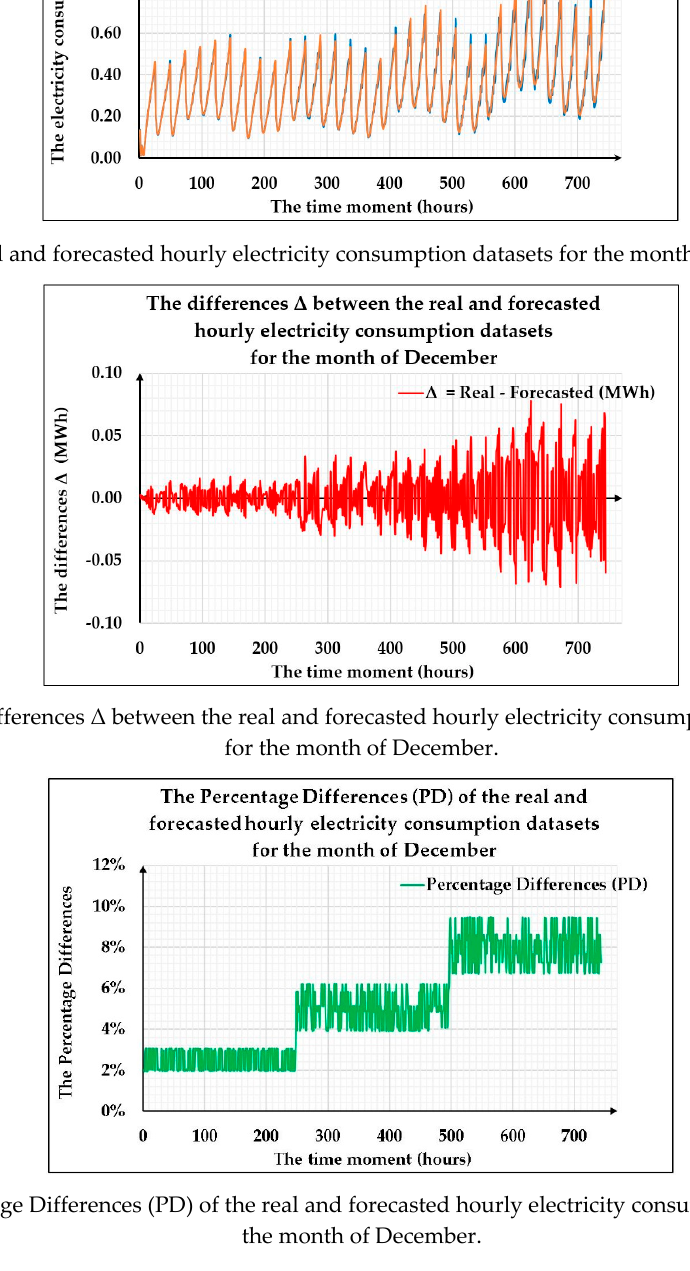
Figure 5. The comparison between the real and forecasted hourly electricity consumption datasets for the month of December.